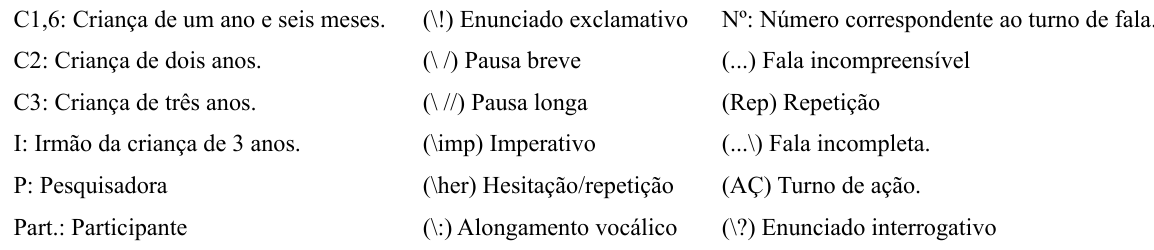
Figura 1 . Legenda interna referente a todas as transcrições presentes neste